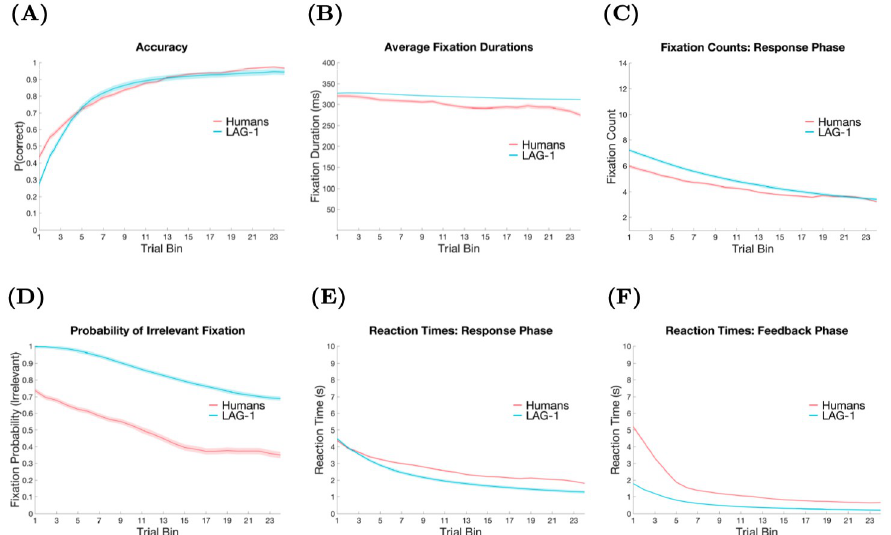
Fig 6. Within-trial feature fixation probabilities. Within-trial feature fixation probabilities averaged across all post criterion point trials and scaled to 100 data points for each trial and averaged into five bins. A) Human data for A categories and with LAG-1’s comparable performance in B. C) Human data for the B categories with LAG-1 again beside it in D. The three important features of the data are: the primacy of Feature one through most of the trial; the primacy of the alternative feature at the end of the trial; and the change in the identity of the second feature across categories (For Category A stimuli it is Feature two, and for Category B stimuli it is Feature three). LAG-1 qualitatively captures all three